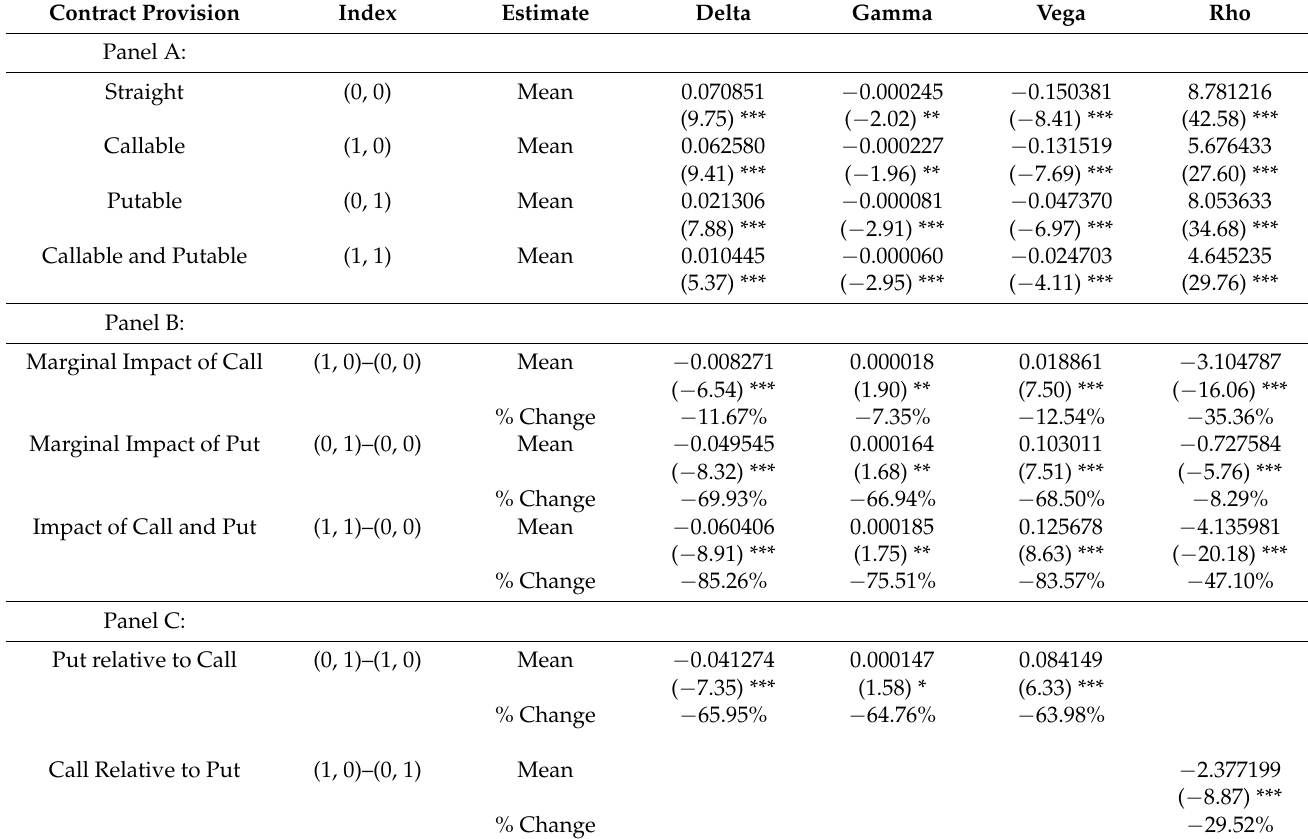
Table 2. Greeks ( Delta , Gamma , Vega , and Rho ) evaluated at the Upper Bound of the firm’s